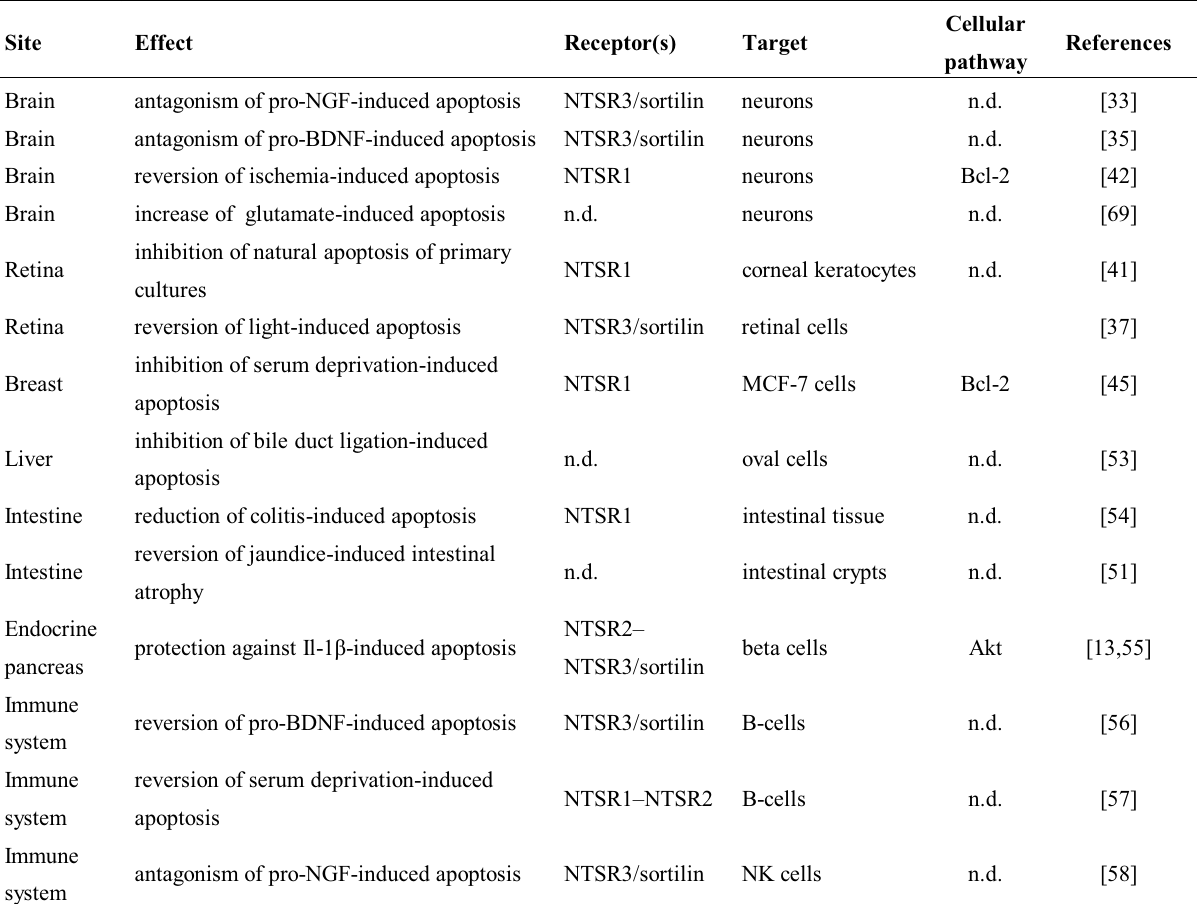
Table 1. Summary of the central and peripheral effects of tridecapeptide neurotensin (NT) on the regulation of cell apoptosis (n.d.: not determined).